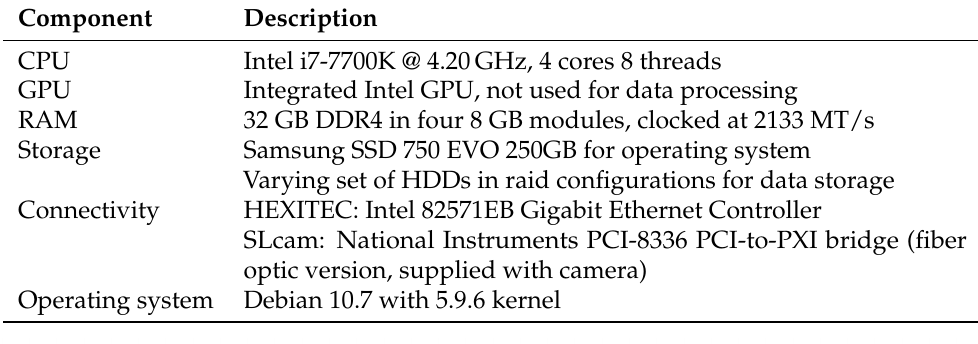
Table 1. Hardware components in the workstation used to run all acquisition and on-line processing described in this work.